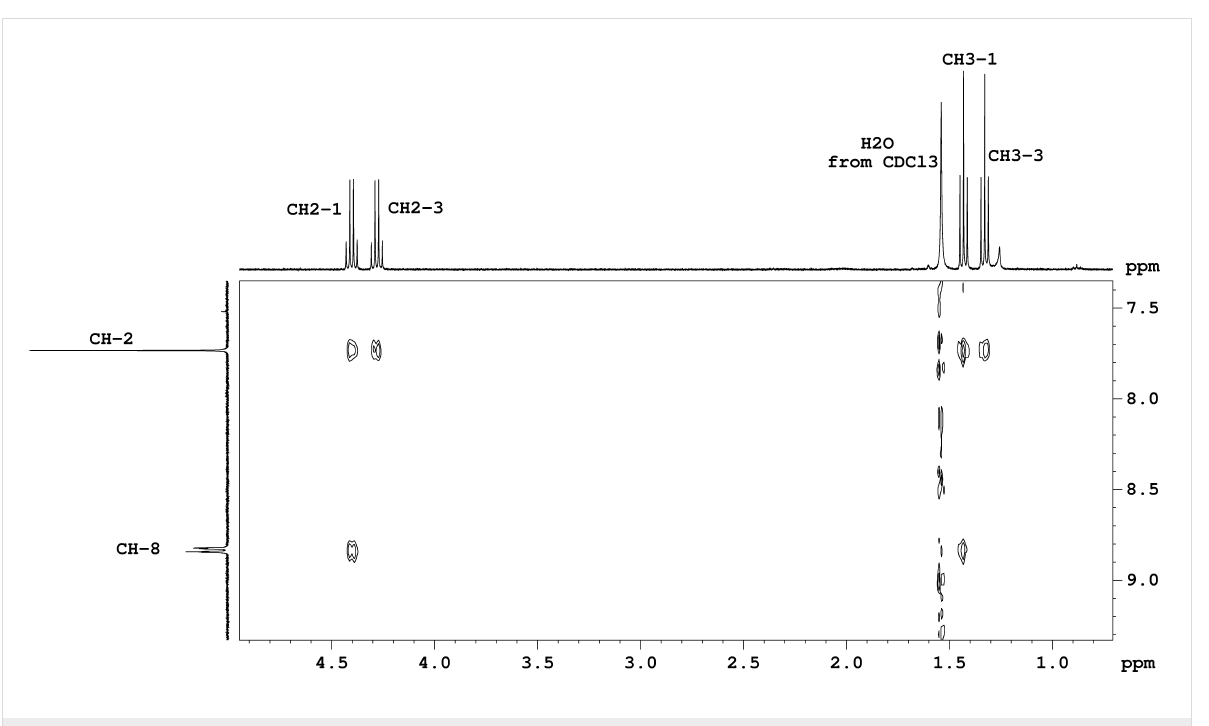
Figure 3: NOE response as cross peaks between carbethoxy group protons and protons from positions 2 and 8 of the heterocycle in a detail from the H,H-NOESY spectrum for compound 5b